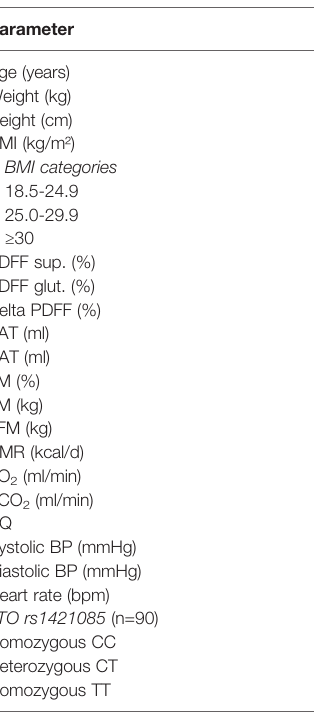
TABLE 1 | Characteristics of the study